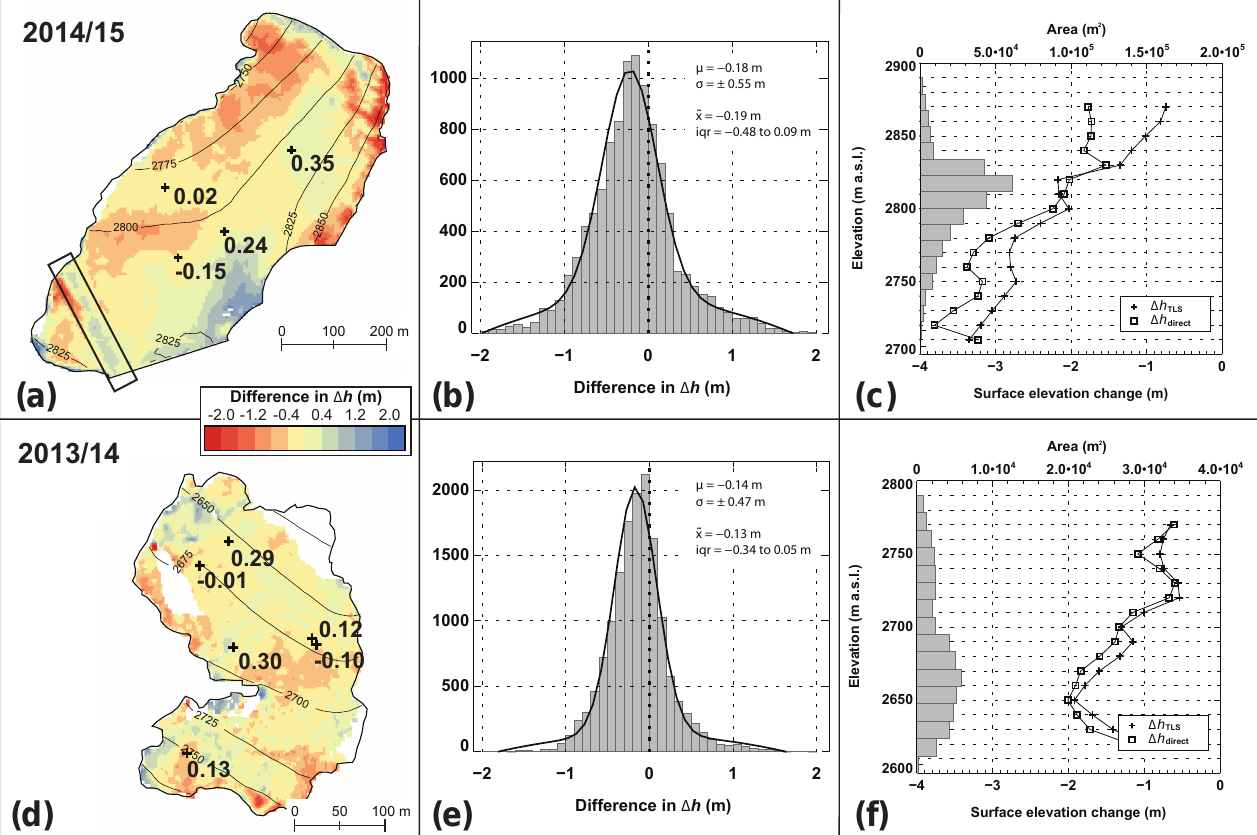
Figure 7. Difference between TLS-derived surface elevation changes and extrapolated glaciological mass balances which were converted to surface elevation changes by multiplication with the respective reciprocal values of zonal conversion factors. Spatial and corresponding frequency distributions as well as distributions of these changes vs. surface hypsometry for (a, b, c) Glacier du Sex Rouge (2014/15) and (d, e, f) Pizolgletscher (2013/14). The numbers in (a) and (d) indicate the differences (in m) between TLS-derived and in situ measured annual elevation changes at ablation stakes ( (cid:49)h TLS minus (cid:49)h direct ). The rectangle in (a) highlights a linear feature originating from a glacier walk maintained by snowcats. The black curves in (b) and (e) are normal fits over the data. In addition, the mean ( µ ) and median ( e x ) elevation differences, as well as corresponding standard deviations ( σ ) and interquartile ranges (iqr) are